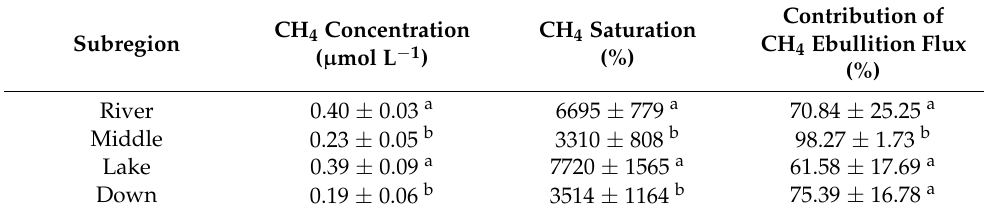
a,b Values having different subscript letters in the same column are significantly different from each other ( p <